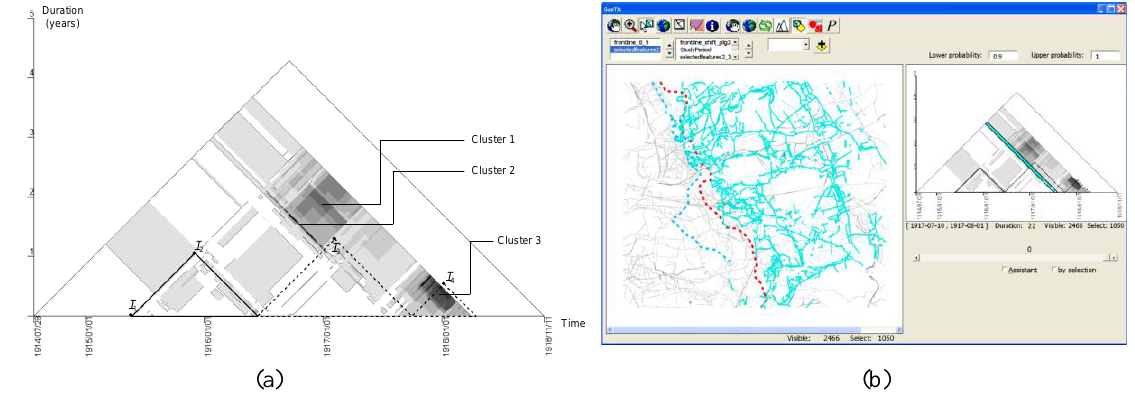
Figure 8. ( a ) Visualizing rough time intervals of the military features in the WWI aerial photos. The dark areas are clusters of the intervals and I 1–4 indicate difference phases (time intervals) of the war. ( b ) Selecting features of Cluster 2 (artillery attack from the Allies army) in the GeoTM (modified from [17]).